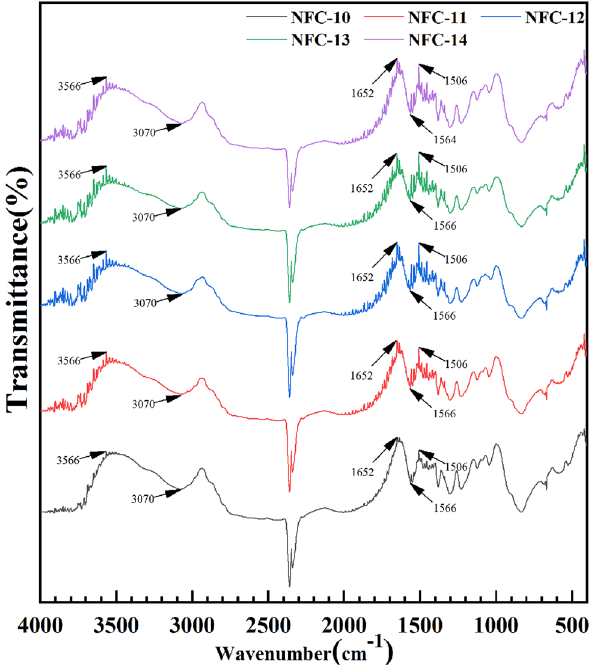
Figure 2: FT - IR spectra pro fi les of intelligent PDMAA hydrogels with various NFC contents.